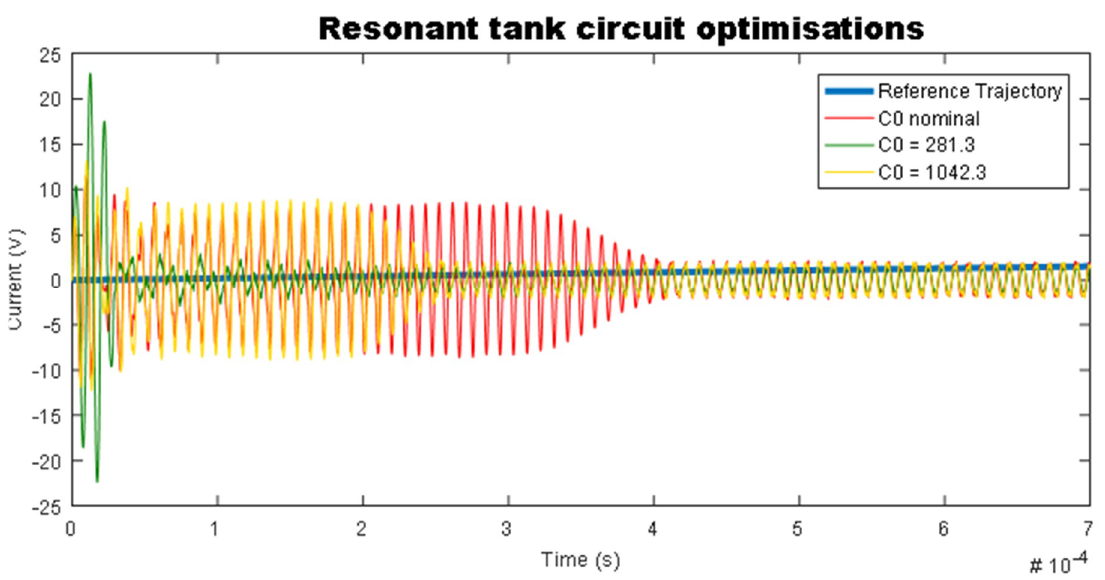
Figure 11. Optimization procedures of the resonant tank circuit elements.